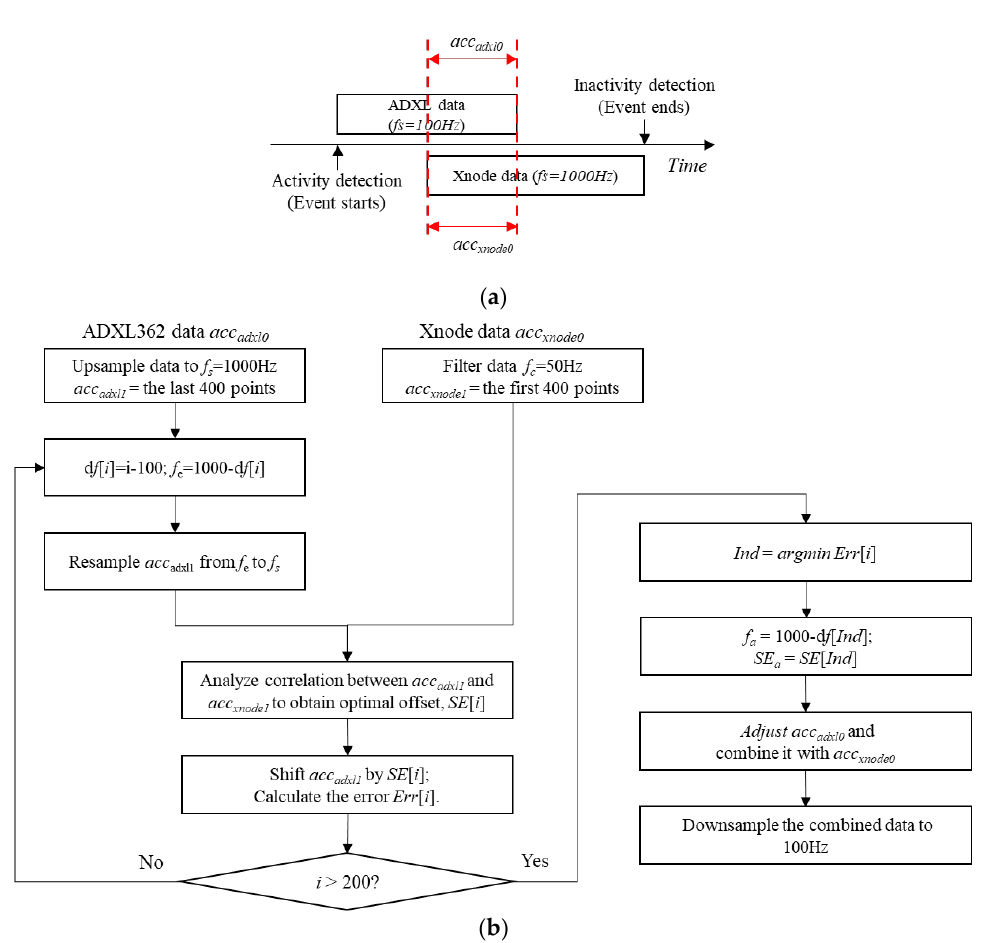
Figure 5. Post-sensing data fusion: ( a ) illustration of two data sources, ( b ) flowchart of data fusion strategy.